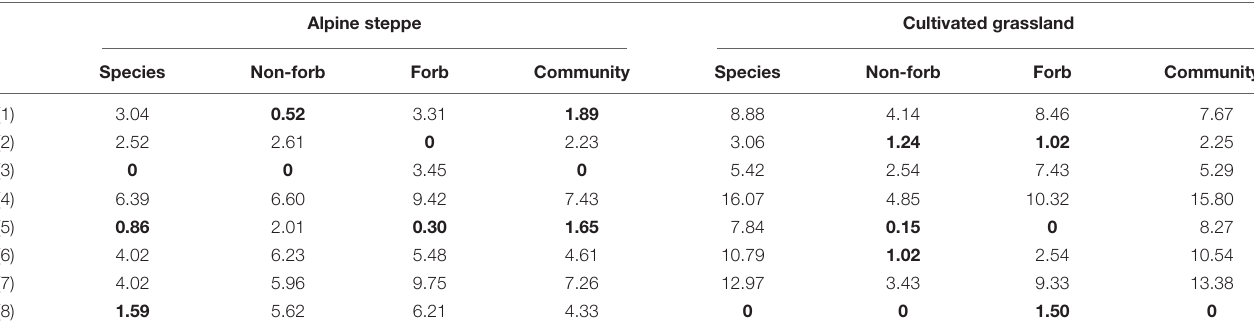
TABLE 2 | (cid:49) AIC values of the linear mixed models of SLA and community weighted mean value of SLA of alpine steppe and cultivated grassland. Alpine steppe Cultivated grassland Species Non-forb Forb Community Species Non-forb Forb Community